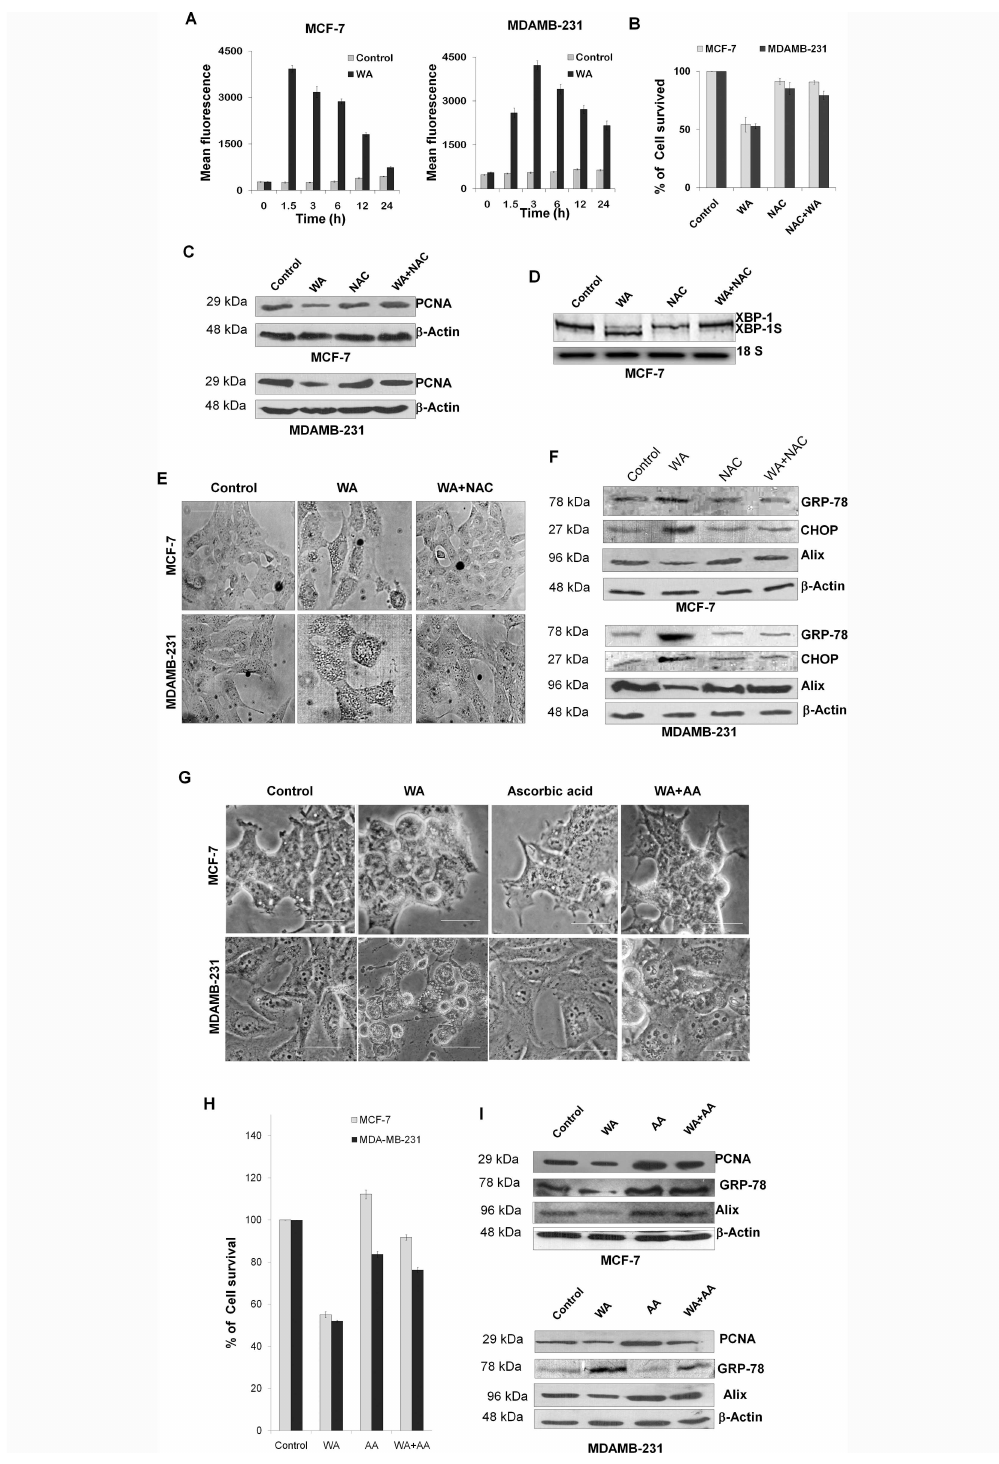
Fig 4. Effect of WA intrinsic ROS generation, ROS mediated ER-stress and paraptosis. (A) The inter-cellular ROS generationin WA-treated MCF-7 and MDA-MB-231 cells was measured flow cytometrically by the intensity of H 2 -DCFDA fluorescence. Bar diagram showingmean fluorescence intensity plotted againstdifferent time intervals where each point representsas the mean ± SEM of triplicate experiments (P < 0.05 corresponding to control, n = 3). (B) C ell growth inhibitionofMCF-7 and MDA-MB-231cellstreated with/without WA (4 μ M) for 24h in